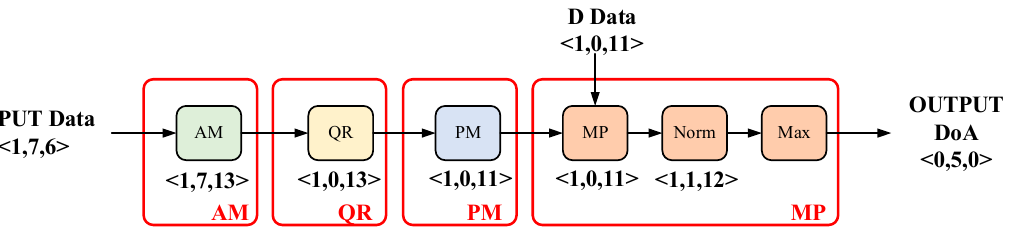
Figure 12. Word length specs for the computing modules.